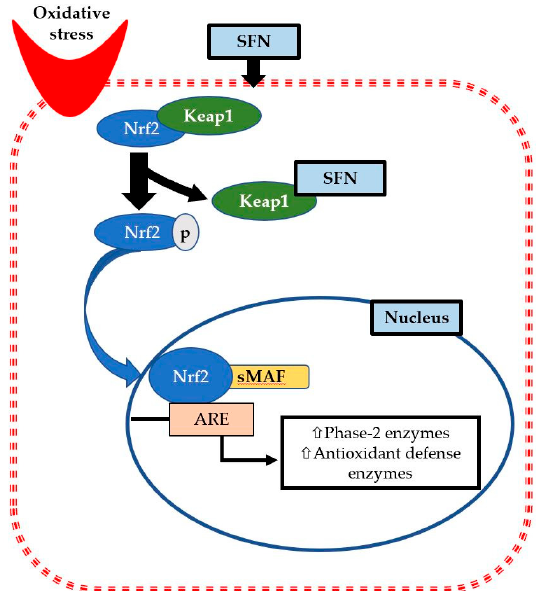
Figure 1. Sulforaphane (SFN) reduces oxidative stress via phosphorylation and accumulation of nuclear factor E2 factor-related factor (Nrf2) inside the nucleus. Therefore, it binds with the small musculoaponeurotic fibrosarcoma (sMAF) protein to activate specific antioxidant responsive element (ARE) present in gene promoter. Then, it elicits transcription of various phase 2 detoxification enzymes and antioxidant defense enzymes such as glutathione S-transferase (GST), heme oxygenase 1 (HO-1), NADPH quinone oxidoreductase (NQO), and thioredoxin reductase (TR) to reduce oxidative stress.